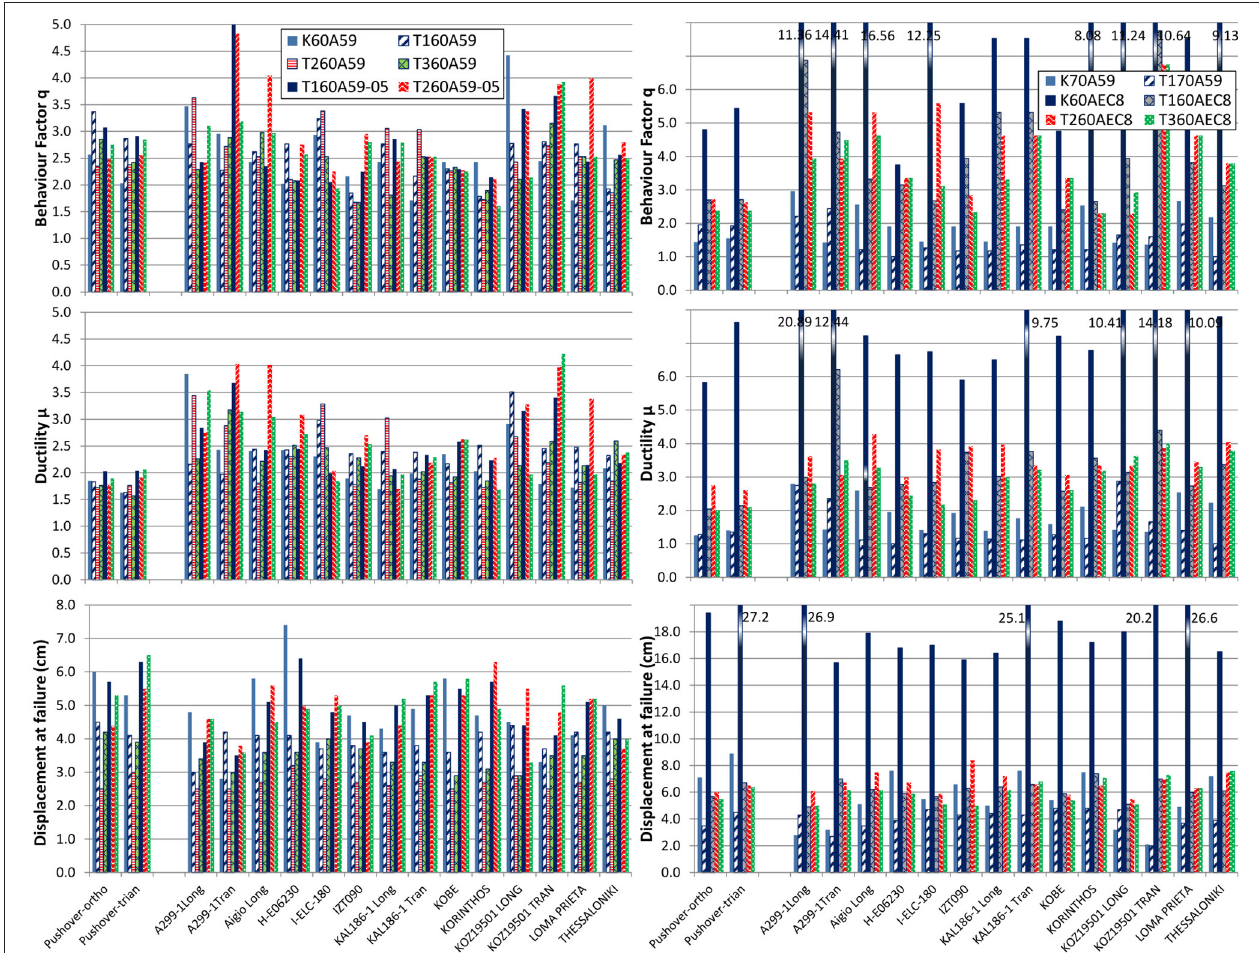
FIGURE 8 | Behaviour factor q , ductility µ and top displacement at failure evaluated from SPO and IDA analyses. (Note that building K60AEC8 results are out of